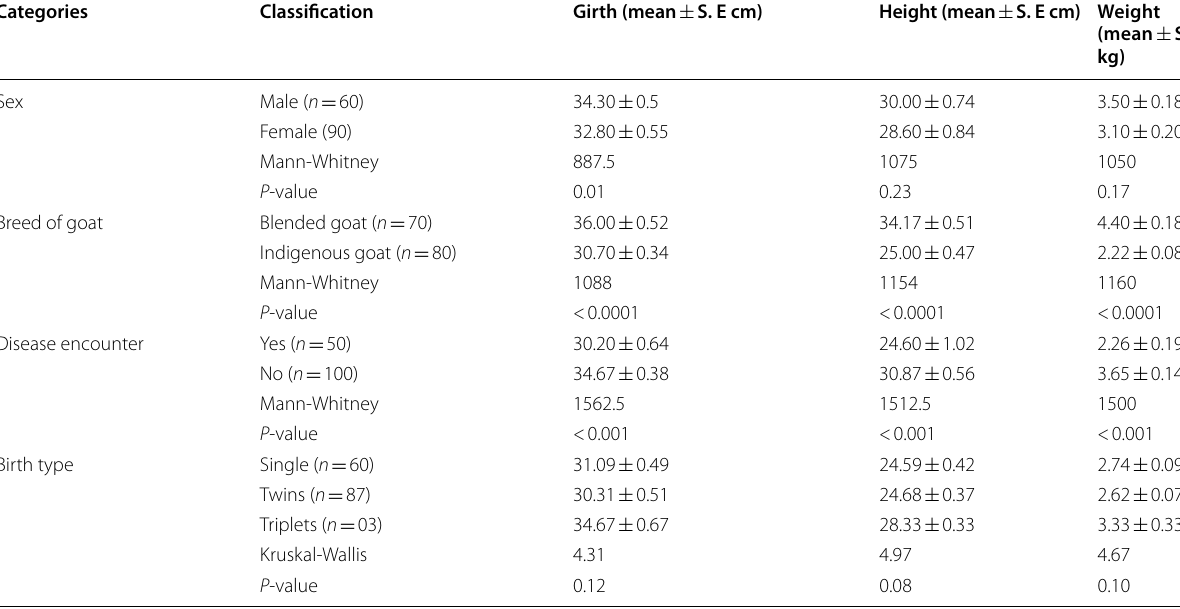
Table 1 The performance of goats in terms of growth under different breeds, sex, and disease encounters